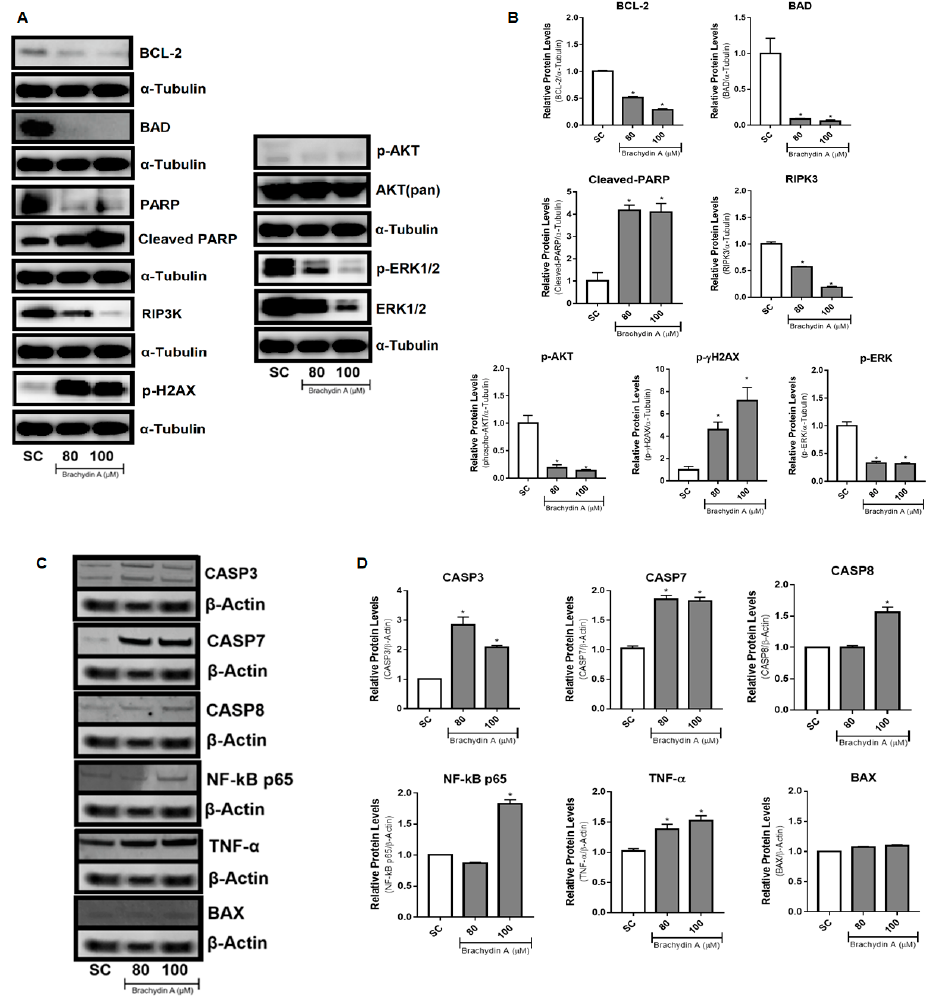
Figure 7. Western blotting analysis of protein expression and densitometric quantifications in DU145 spheroids treated with BrA for 24 h ( A , B ) and 72 h ( C , D ). Protein expression was normalized with α -Tubulin (24 h) and β -Actin (72 h) from the SC group. All bars are presented as mean ± standard deviation of experiments performed with ninety-six ( n = 96) spheroids/replicates and two biological experiments ( n = 2). * Statistically different values from the SC group ( p < 0.05; ANOVA followed by Dunnett’s post-test). SC: solvent control (1%